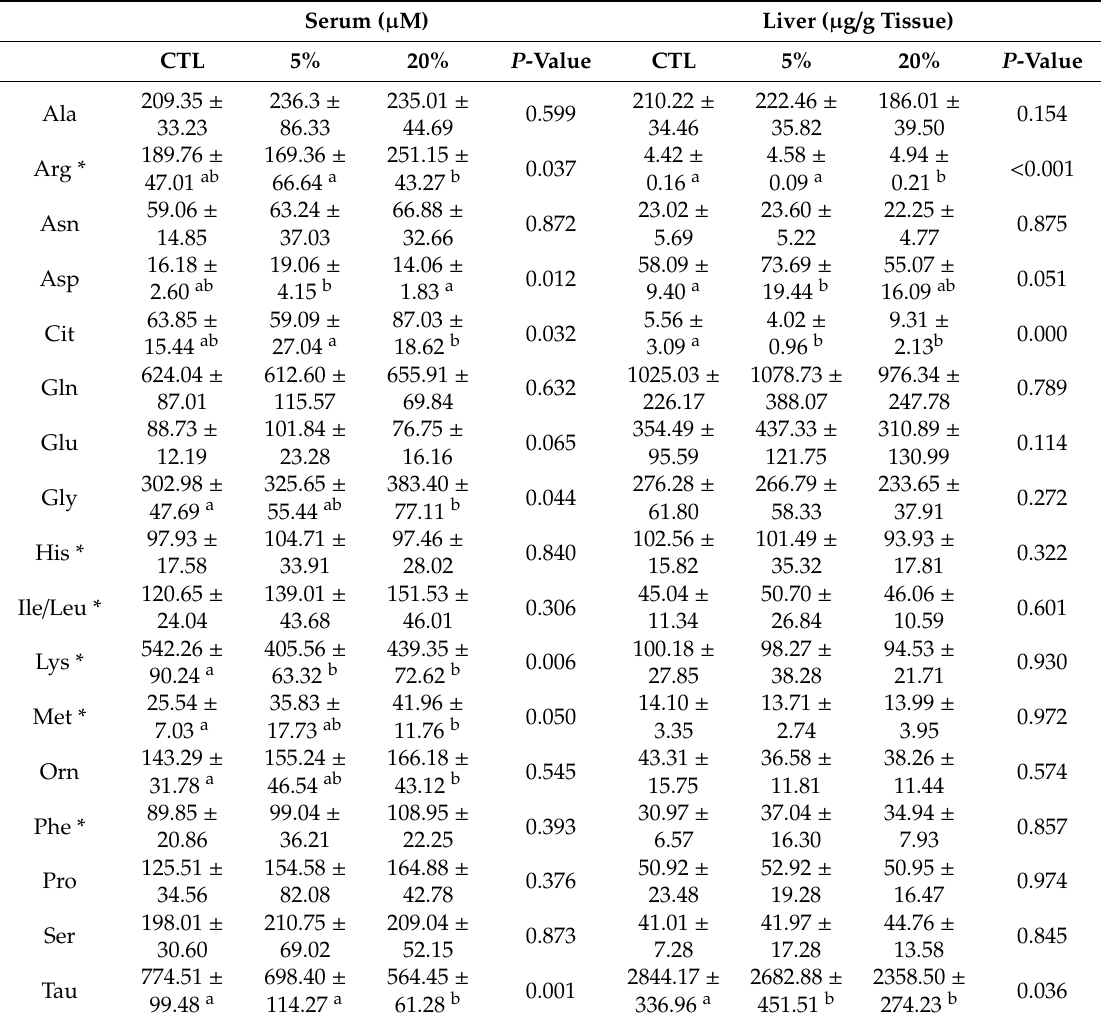
Table 2. Concentrations of free amino acids (FAAs) in serum and